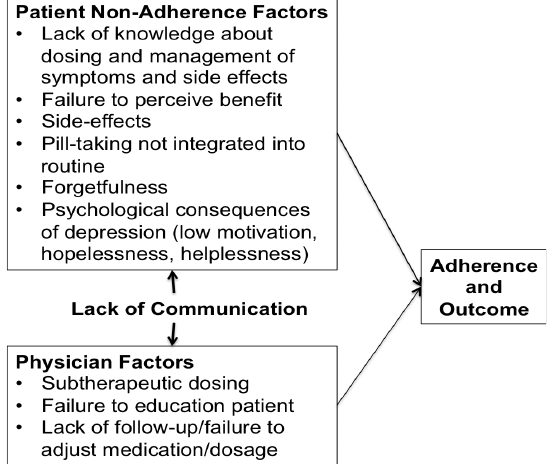
Fig. 1: Failure Points in Antidepressant Therapy Thus, patients beginning antidepressant treatment for depression have little knowledge, initially experience side effects, expect but receive little immediate benefit, and are prone to forgetfulness, low motivation, hopelessness and helplessness, all of which increases the likelihood that they will discontinue their